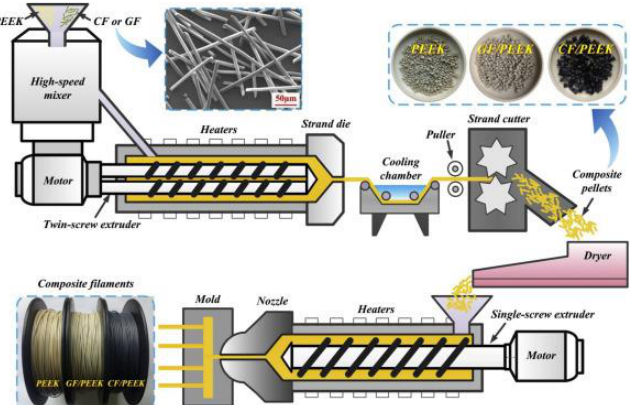
Figure 13. Preparation process of composite filaments, for M1 embedding before the printing process Reprinted with permission from [125], 2020, Elsevier, Amsterdam, The Netherlands.